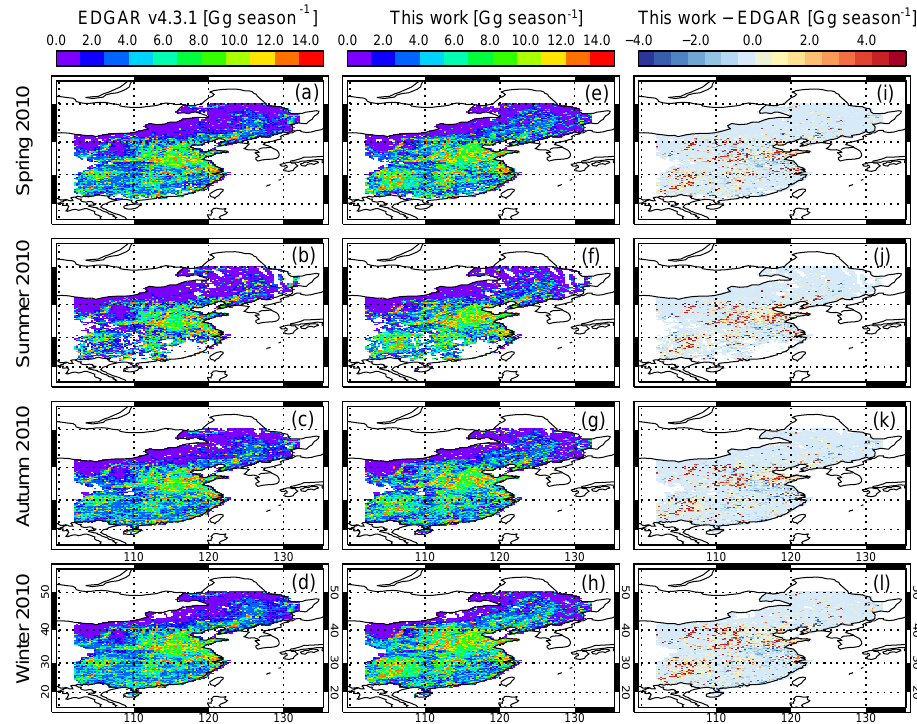
Figure 7. The seasonal variability of the a posteriori emissions calculated in this work (e–h) in Gg season − 1 compared to the EDGAR v4.3.1 emissions (a–d) in Gg season − 1 as well as their absolute differences (i–l) . From top to bottom; spring, summer, autumn and winter of the reference year